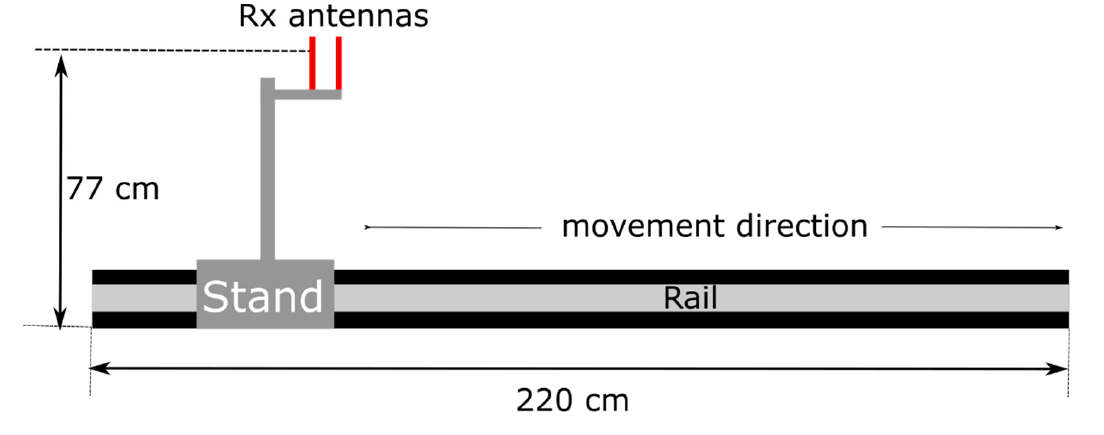
Figure 1. Measurement setup of the receiver.